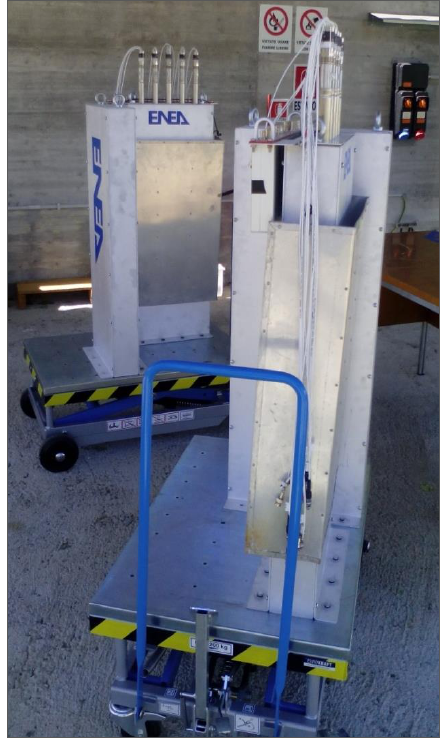
Figure 4. The NAI device experimental setup on the field.